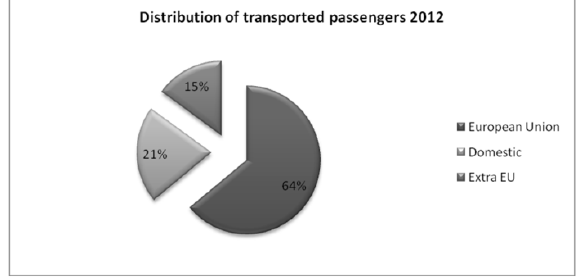
Fig. 2. Distribution of transported passengers from Spain, 2012